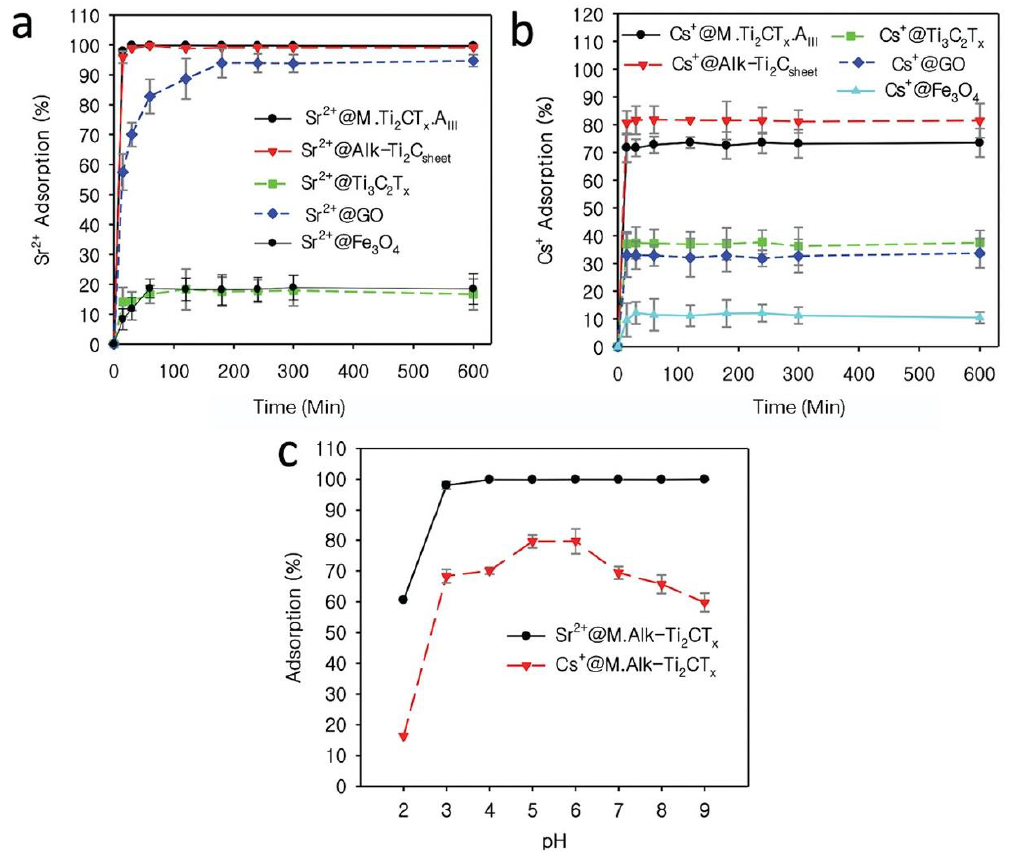
Figure 4. Comparison of adsorption efficiency of different materials for ( a ) Sr 2+ and ( b ) Cs + in deionized water. M.Ti 2 CT x -A III exhibited exceptionally high removal capacity for both Sr 2+ and Cs + radionuclides. ( c ) Effect of solution pH on Sr 2+ and Cs + adsorption by M.Ti 2 CT x -A III . Table 3. Comparison between M.Ti 2 CT x -A III and other benchmark materials for maximum adsorption capacity of Sr 2+ and Cs + adsorption.